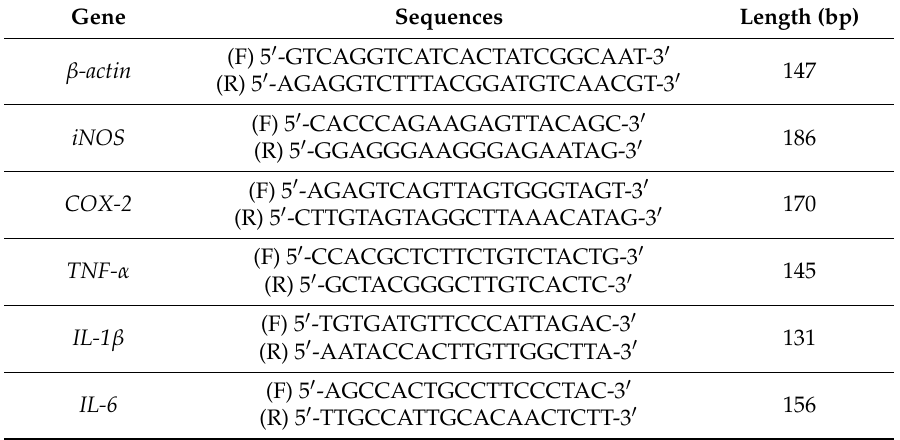
Table 1. The primer sequences of β -actin , inducible nitric oxide ( iNOS ), cyclooxygenase-2 ( COX-2 ), TNF- α , IL-1 β , and IL-6